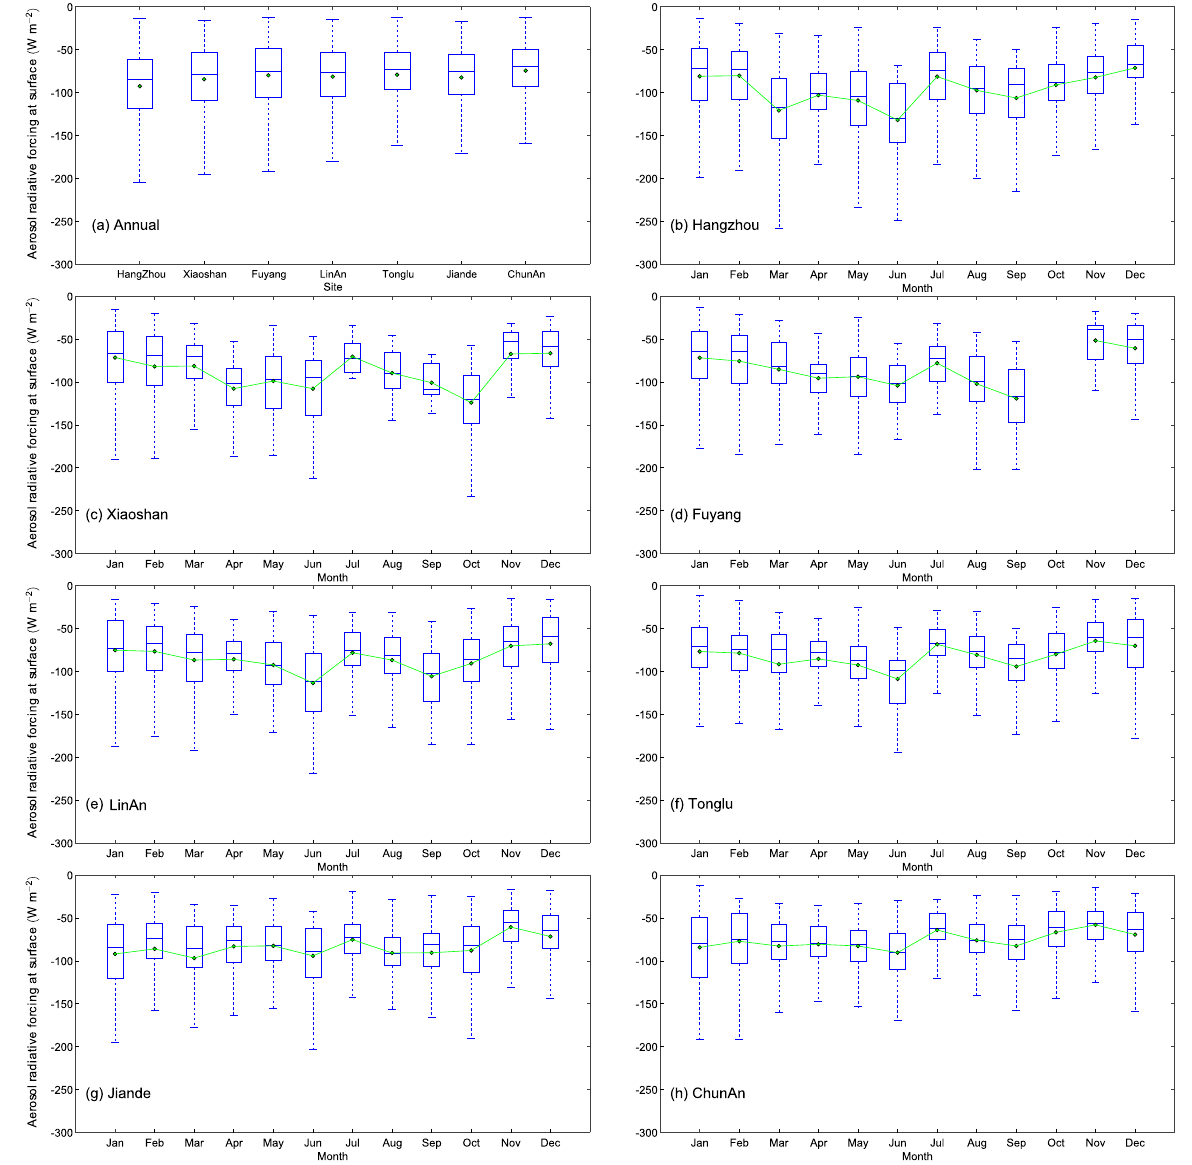
Figure 6. (a) Annual variations of monthly mean direct aerosol radiative forcing (50–80 ◦ SZA) at the bottom of the atmosphere over (b) Hangzhou, (c) Xiaoshan, (d) Fuyang, (e) LinAn, (f) Tonglu, (g) Jiande and (h) ChunAn. See Fig. 3 for an explanation of the